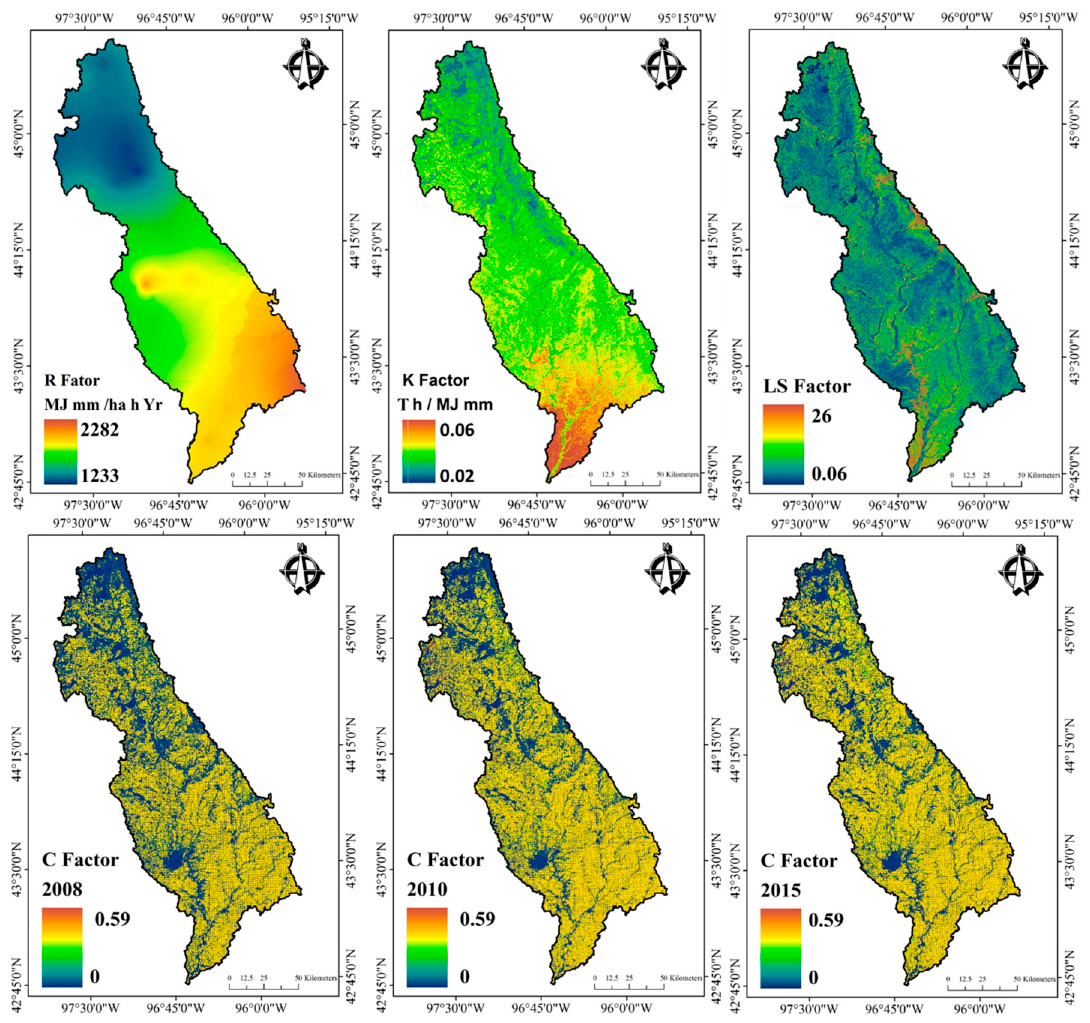
Figure 4. The parameters (R; K; LS; C for 2008, 2010 and 2015) used in RUSLE in order to estimate soil erosion in the watershed located in Northern Great Plains of USA.